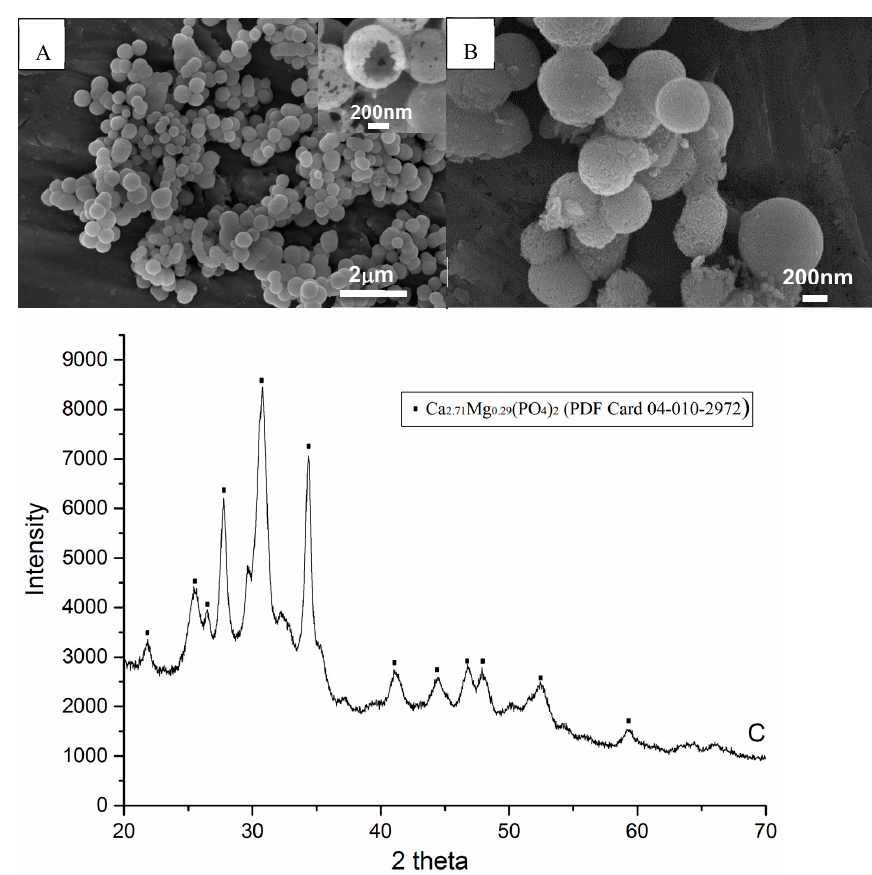
Figure 1. SEM images and XRD pattern of hollow calcium phosphate spheres synthesized by hydrothermal method. ( A ) Spheres dried at 60 °C for 2 h after synthesis; ( B ) Spheres loaded with hydrogen peroxide for 2 h; ( C ) X-ray diffraction pattern of (A), which indicates that the composition of spheres is magnesium substituted calcium phosphate.